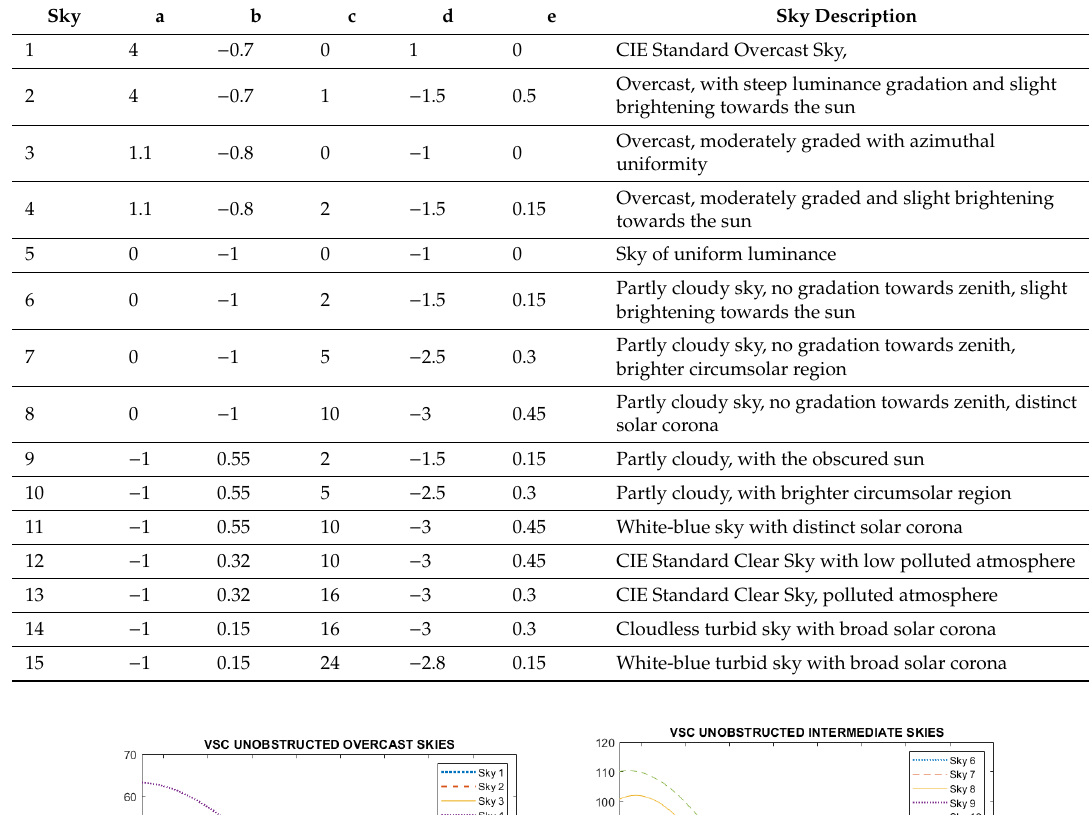
Table 4. Parameters of CIE standard sky types [22].